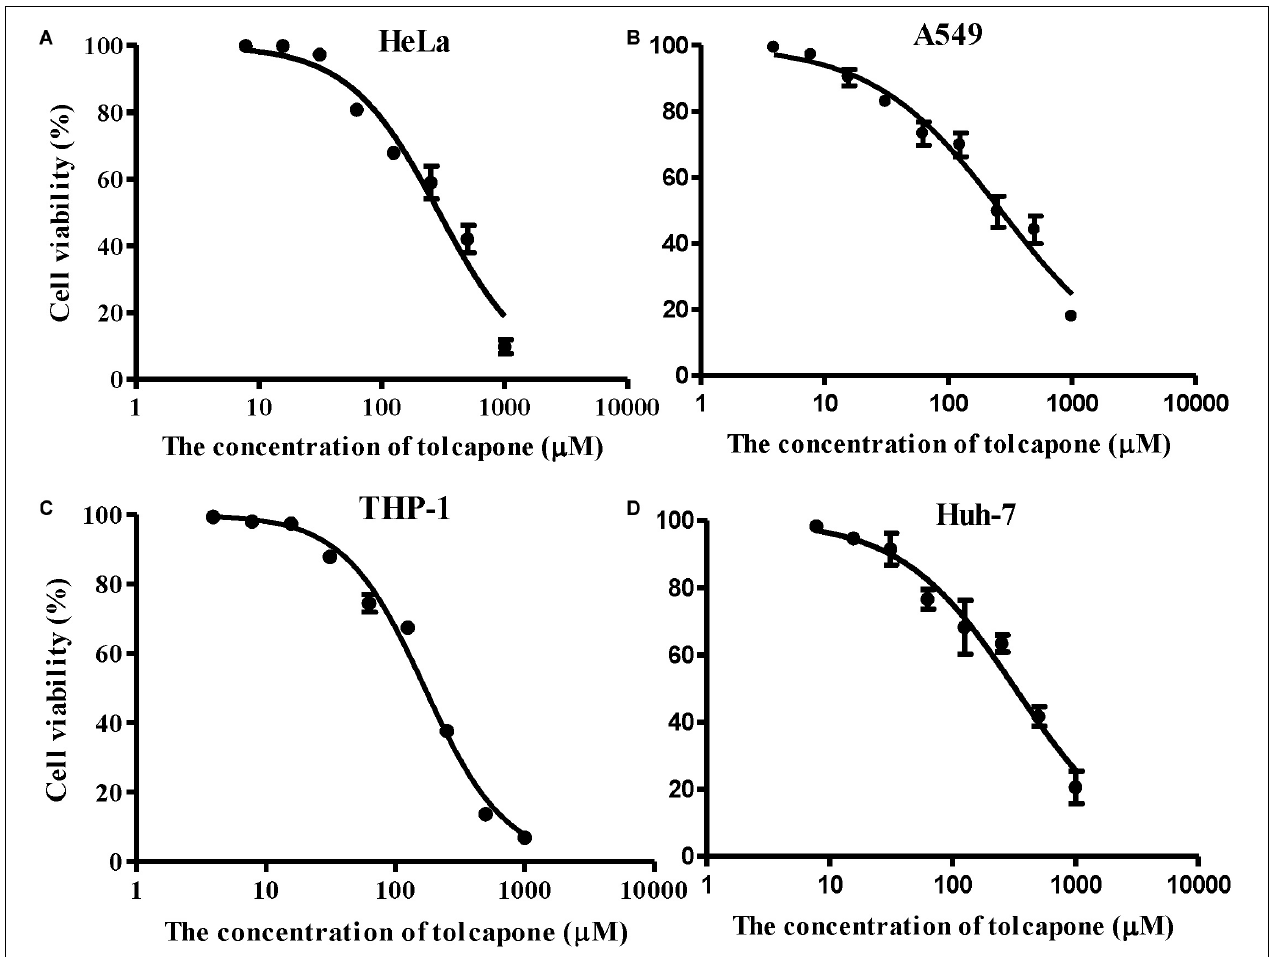
FIGURE 8 | Cytotoxicity of tolcapone in vitro . (A) HeLa, (B) A549, (C) THP-1, and (D) Huh-7 cells. The concentrations of tolcapone were double diluted from 1,000 to 7.81 µ M. Cytotoxicity was evaluated by 3-(4,5-dimethylthiazol-2-yl)-2,5-diphenyltetrazolium bromide (MTT) assay.